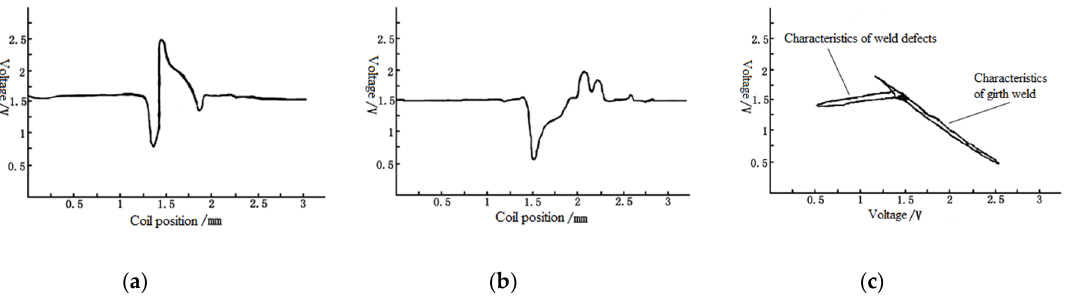
Figure 5. Original signal and impedance diagram of a defect in the girth weld. ( a ) Real part of the defect signal. ( b ) Imaginary part of the defect signal. ( c ) Impedance diagram of the defect at the girth weld.